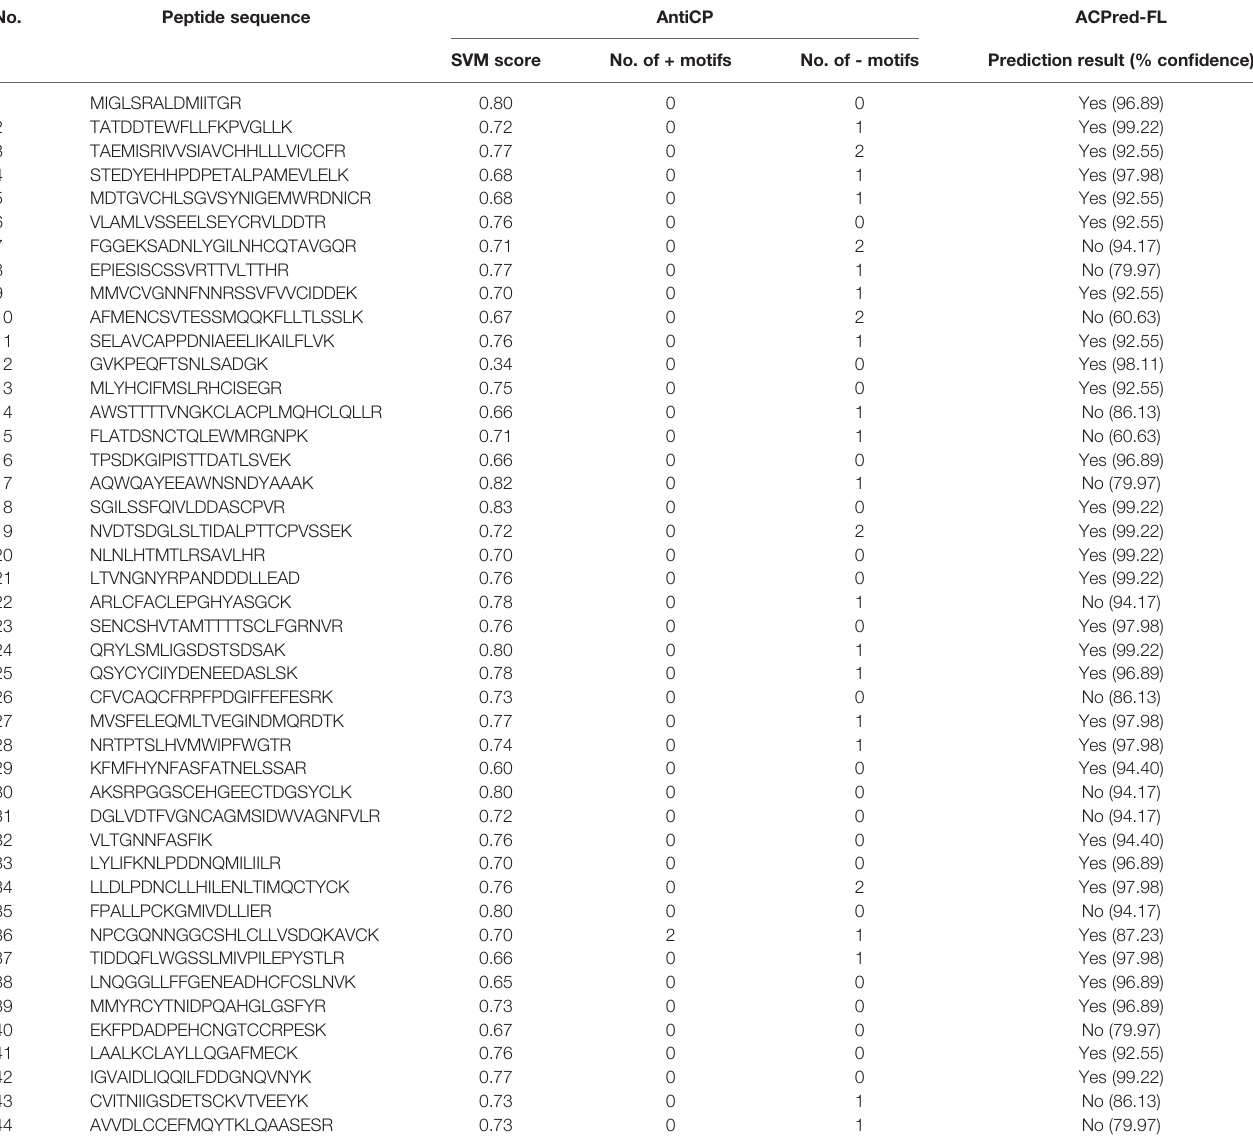
TABLE 2 | Prediction of antitumor peptides of 44 proteins identi fi ed from muscle larval extract (LE) using AntiCP and ACPred-FL prediction tools.